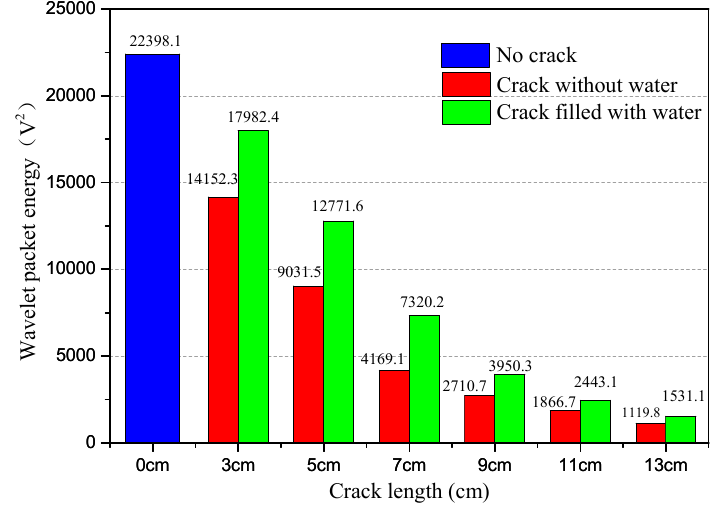
Figure 15. WPEIs of collected signals for all test cases.